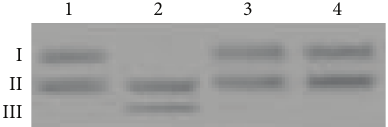
Figure 6: Cleavage of the plasmid DNA by zinc finger proteins. Lane 1 is pGEX-B not containing proteins, lane 2 is pGEX-B con- taining ZNF191(243-368)-His 8 , lane 3 is pGEX-B containing His 6 - ZNF191(243-368), and lane 4 is pGEX-B containing ZNF191(243-